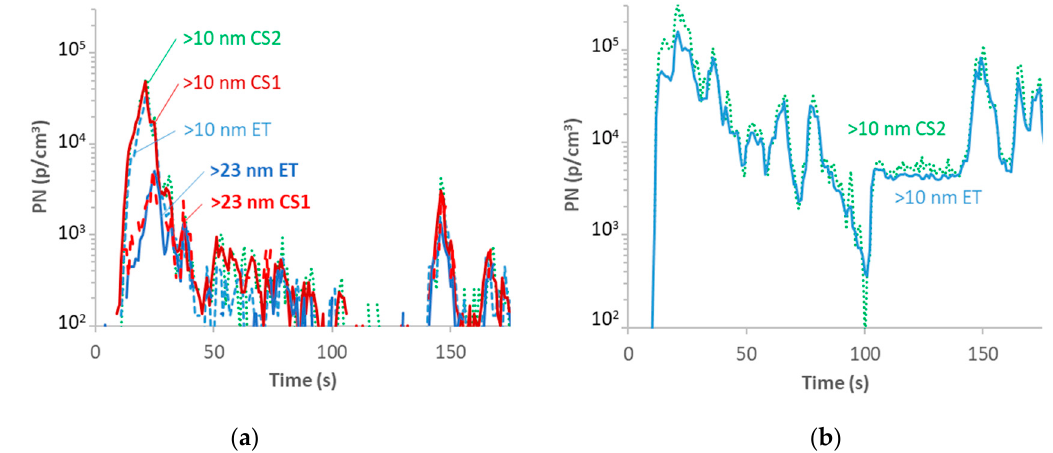
Figure 5. Nonvolatile particle number (PN) emissions during a cold start: ( a ) PN > 23 nm and > 10 nm with instruments with evaporation tube (ET) or catalytic stripper (CS) and ( b ) as panel (a) for a different cold start with preheating of the diesel oxidation catalyst (DOC). All instruments measuring from the dilution tunnel.